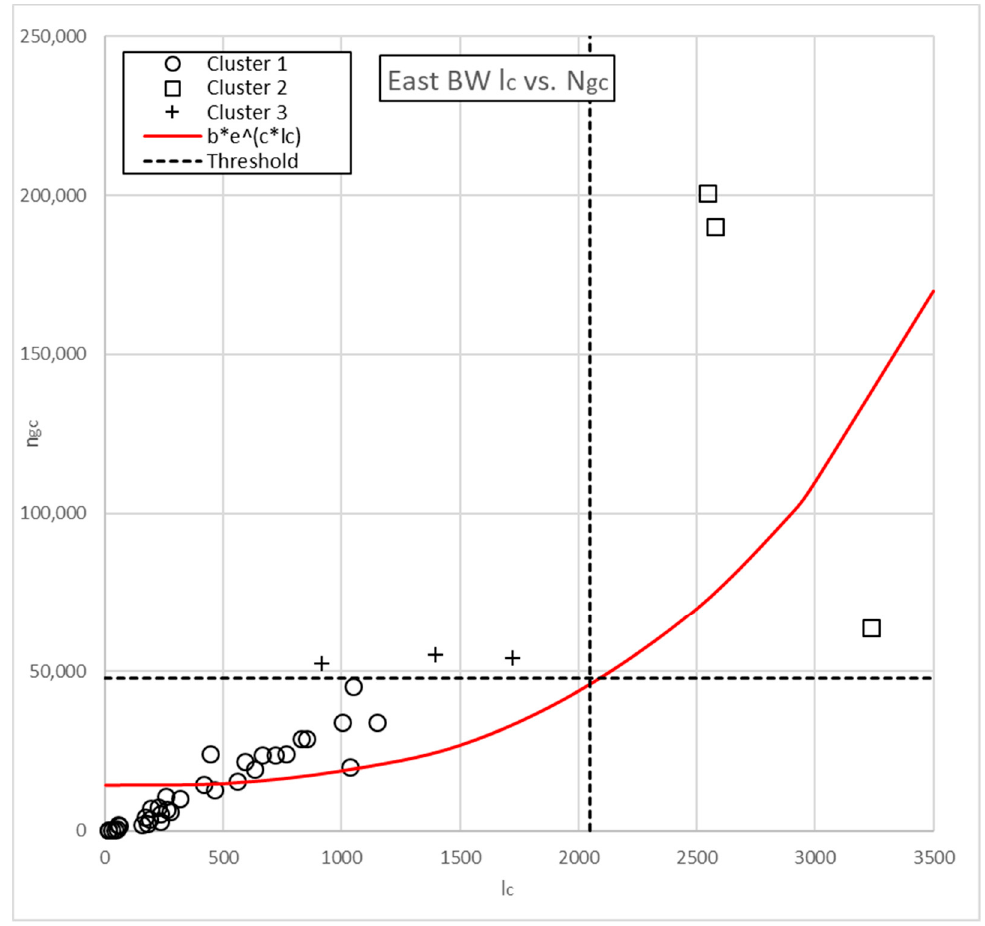
/ n pv gc - W po and of l c -n gc